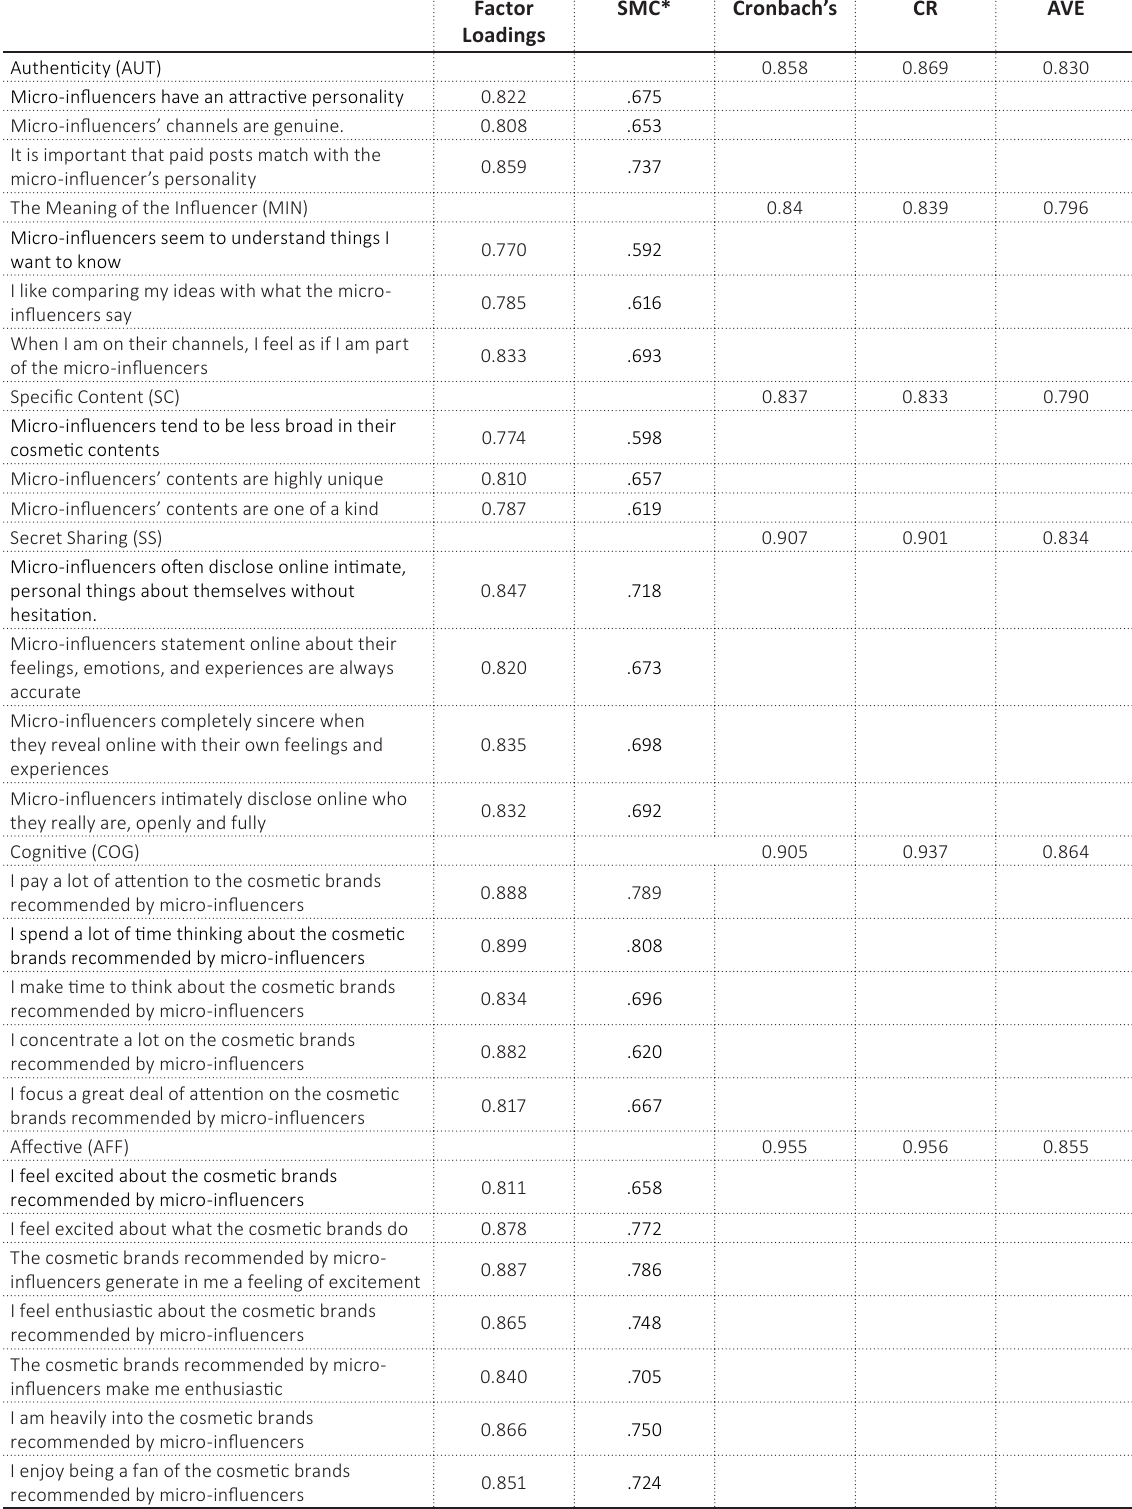
Table A1. Confirmatory factor analysis of the final